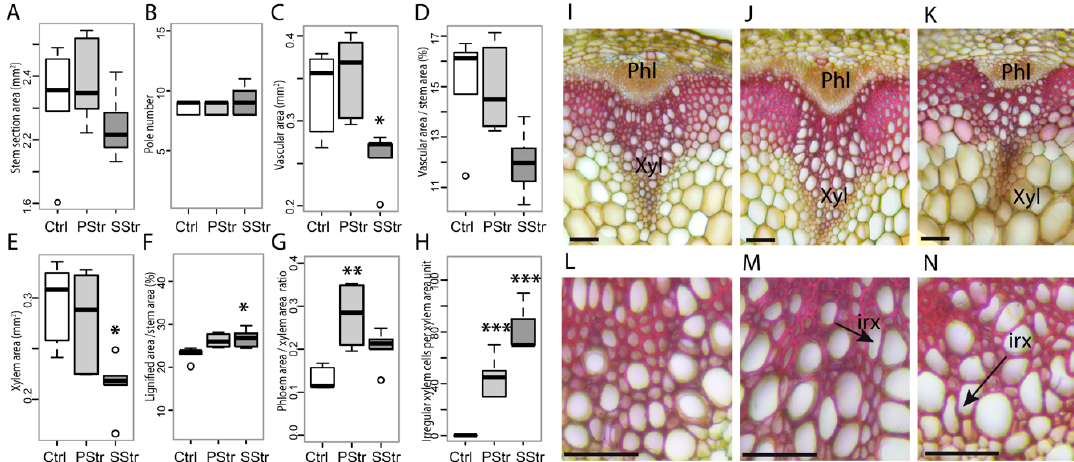
Figure 6. Stem anatomy in response to high salinity. Growth and anatomy of the stem of Ctrl, PStr and SStr plants, with black bars for Ctrl plants, light grey bars for PStr plants and dark grey for SStr plants. In ( A ) to ( H ), the box and whisker plots show the distribution of the biological replicates ( n = 4 to 6). Inside black lines represent medians; the top and bottom ends of the boxes represent the first and the third quartiles, respectively; whisker extremities represent maximum and minimum data points and open circles represent outliers. ( A ) Area of the stem cross section. ( B ) Number of vascular bundles per stem section. ( C ) Total area of the vascular bundles per section. ( D ) Proportion of the vascular bundle area per total stem section area, expressed as a percentage. ( E ) Total xylem area per section. ( F ) Proportion of the lignified area (including interfascicular fibers and xylem) per total stem section area, expressed as a percentage. ( G ) Phloem area-to-xylem area ratios. ( H ) Number of irregular xylem cells-to-xylem section area ratio. A to H : *, ** and *** indicate significant difference of treatments compared to Ctrl plants (* p < 0.05; ** p < 0.01; *** p < 0.001). ( I – N ) Transversal cross section of basal stem stained with Safranin O and Alcyan Blue for Ctrl plants ( I , L ), Sstr plants ( K , N ) and PStr plants ( J , M ). Black arrows indicate the irx cells. Xyl: Xylem, Ph: Phloem. Bar = 50 µm.